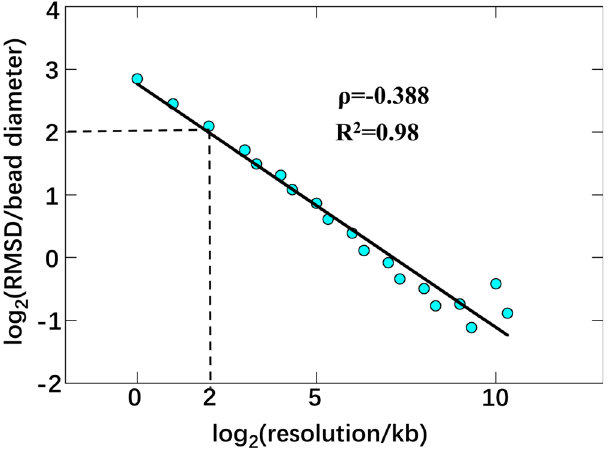
Fig. 6 Estimating how many contact reads per chromatin bead are required for Si-C to achieve reliable 3D structure. Log-scale plot of median RMSD within the structure ensemble of cell 1 against the resolution. The threshold of the median value of pairwise RMSDs for a reliably calculated structure ensemble set to be 4 bead diameters, indicated by the dashed line. RMSD root-mean-square